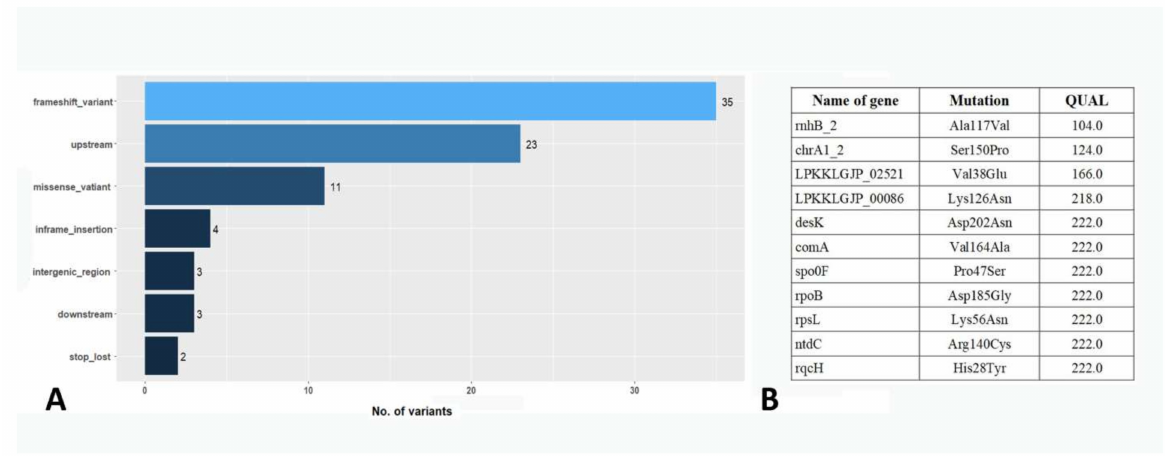
Figure 7. The ratio of nucleotide variants with different effects identified in the 3-19 strain genome ( A ). List of missense variants found in the genome ( B